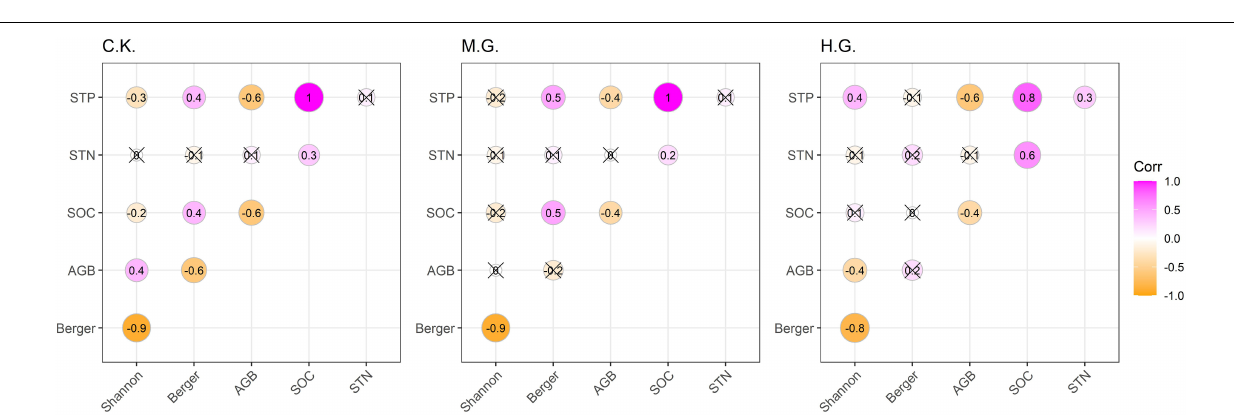
soil, and nutrient) (Zhu et al., 2016). Previous studies